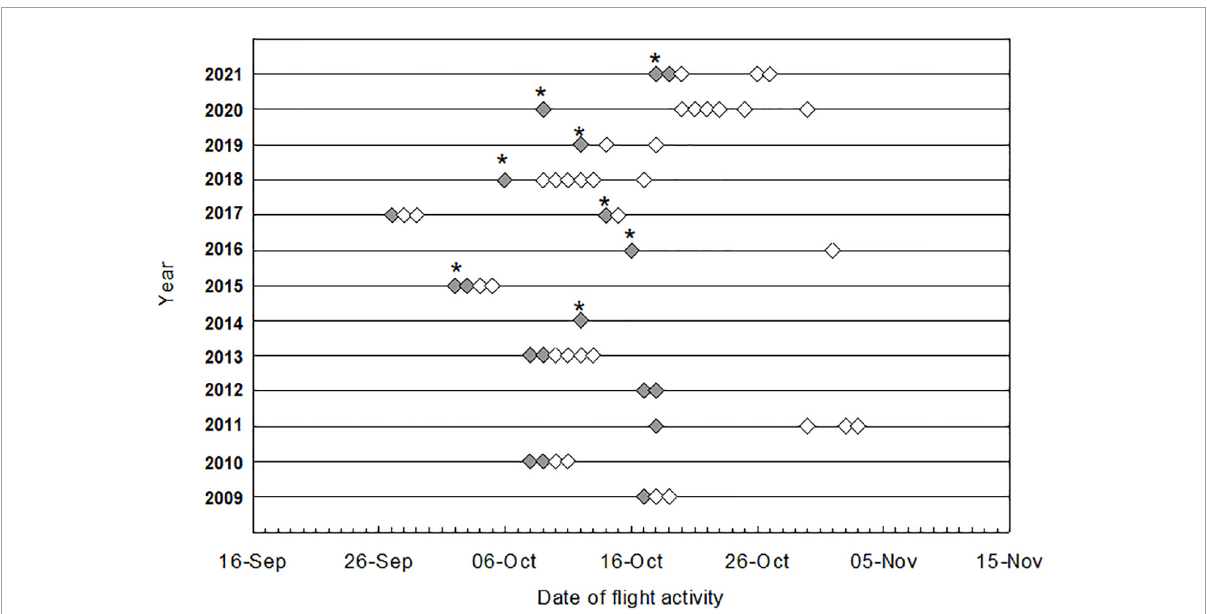
FIGURE2 Days on which immigration flight to the overwintering sites took place. Shaded symbols indicate dates when flight activity was intense, open symbols indicate dates when flight activity was small. Asterisked are the dates when adults were collected for experiments with overwintering in artificial hibernacula (in each year one day when flight activity was high). The picture also contains data obtained in 2009–2013, when experiments with artificial hibernacula were not made.